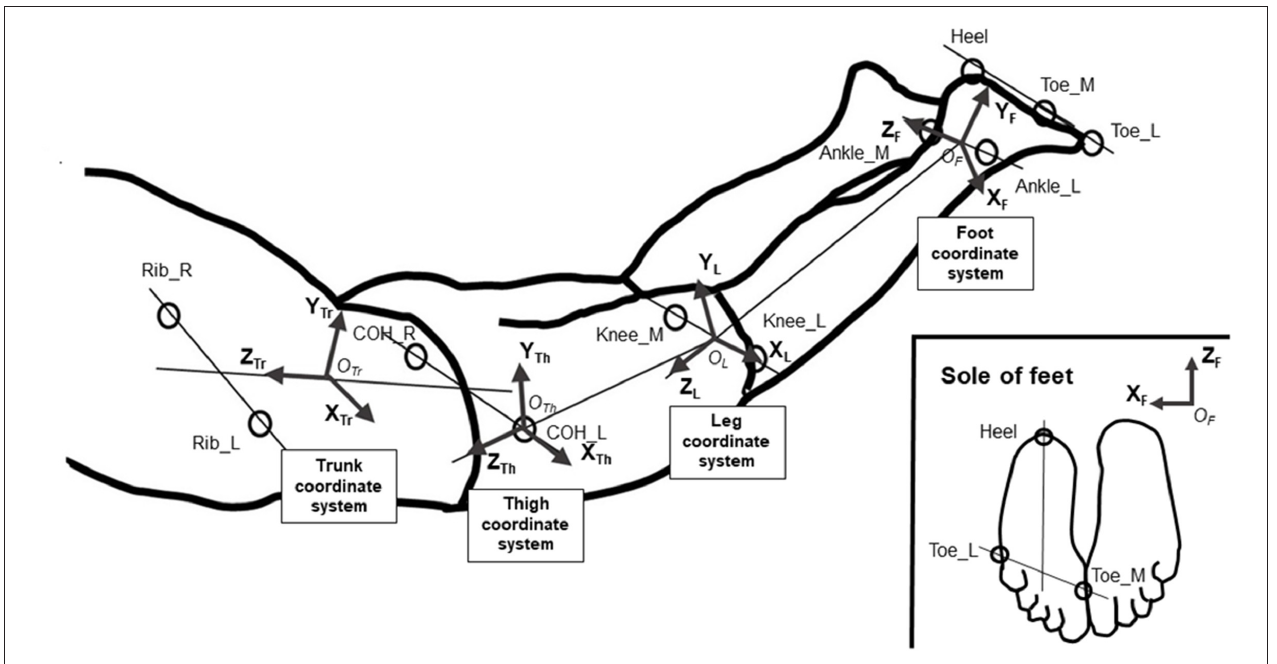
FIGURE 3 | Definitions of the segment coordinate